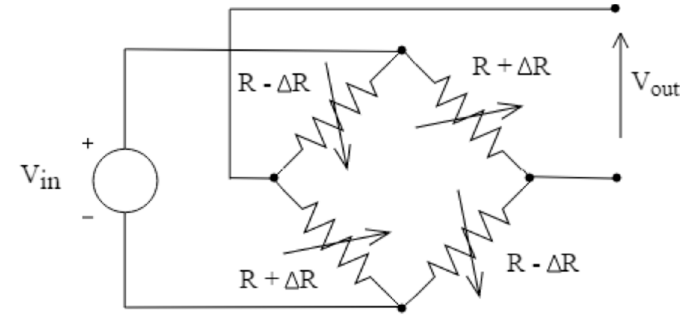
Figure 2. Four-point bridge sensor.